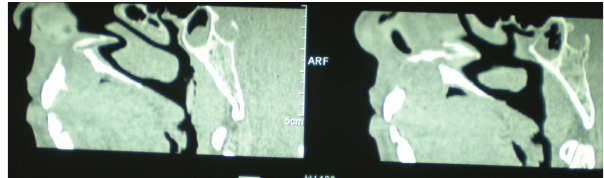
Figure 4: Sagittal sections of CT